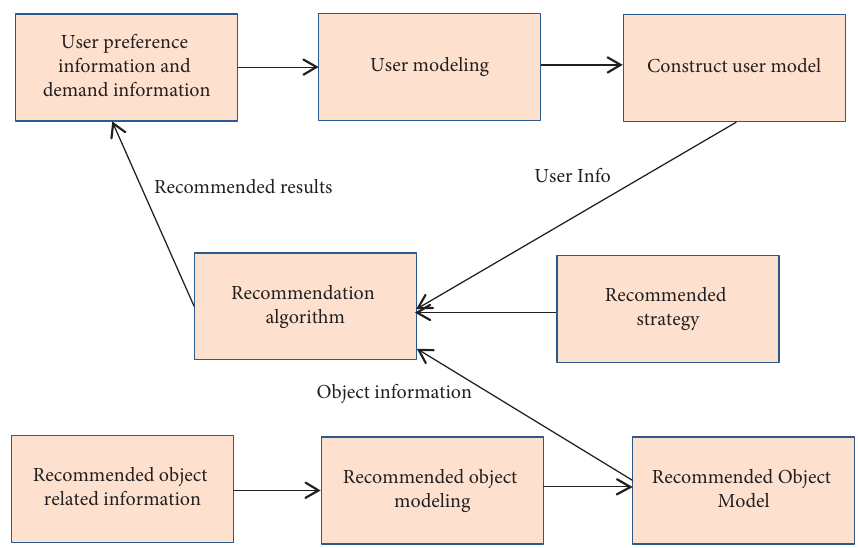
Figure 2: Model flow of the recommendation algorithm.